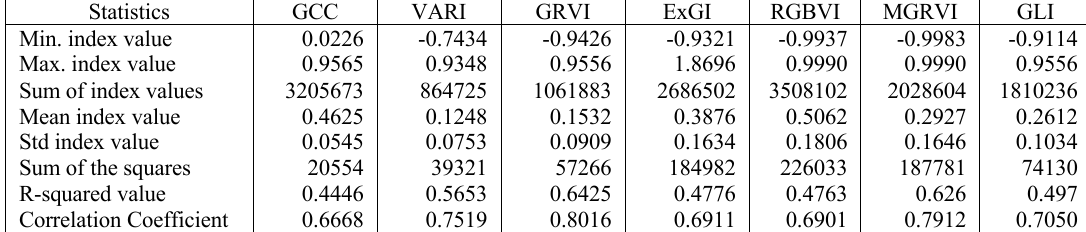
Tabel 2 . The correlation coefficient of VIS-based VI and field observation data